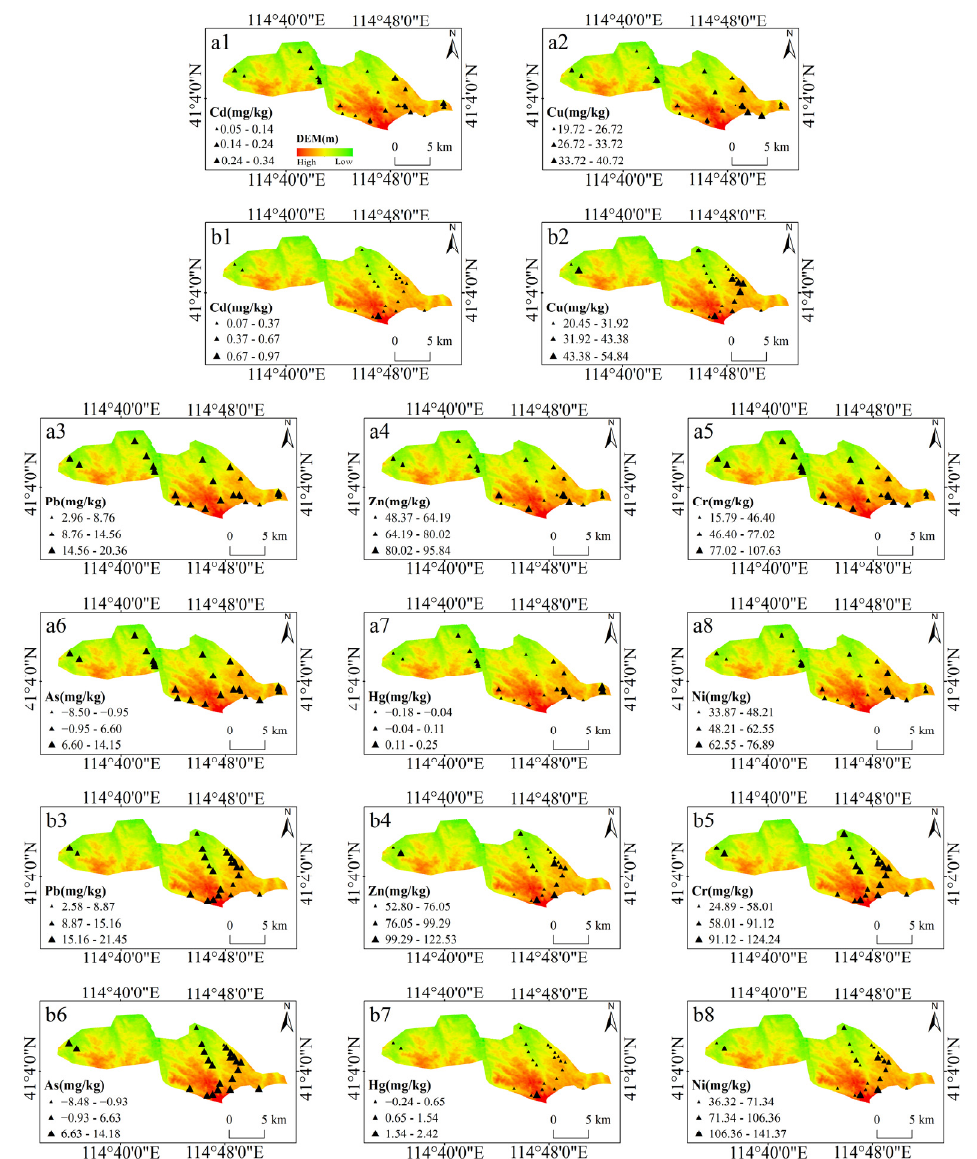
Figure 2. Spatial distribution of eight heavy metal contents in soil planted with potato ( a1 – a8 ) and hulless oats ( b1 – b8 ) from different villages. hulless oats ( b1 – b8 ) from different